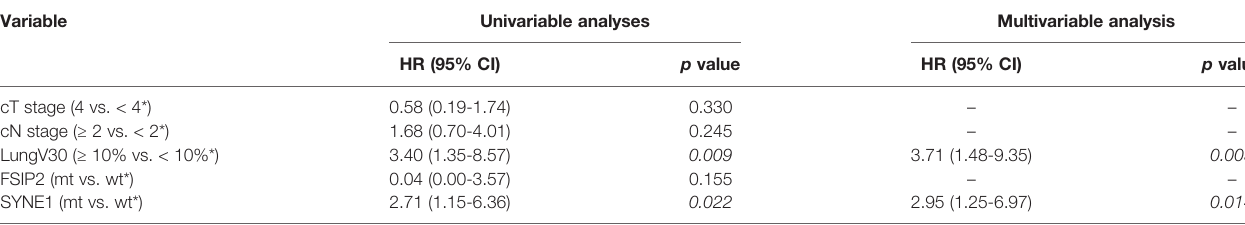
TABLE 3 | Cox regression analysis for overall survival of esophageal cancer patients.